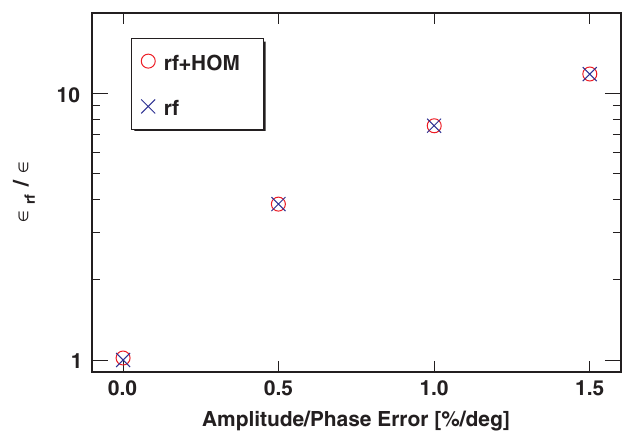
FIG. 18. Average longitudinal phase space increase as function of the rf error with and without a HOM. Settings: uniform distributed rf errors, N ¼ 1000 , see Table VI.